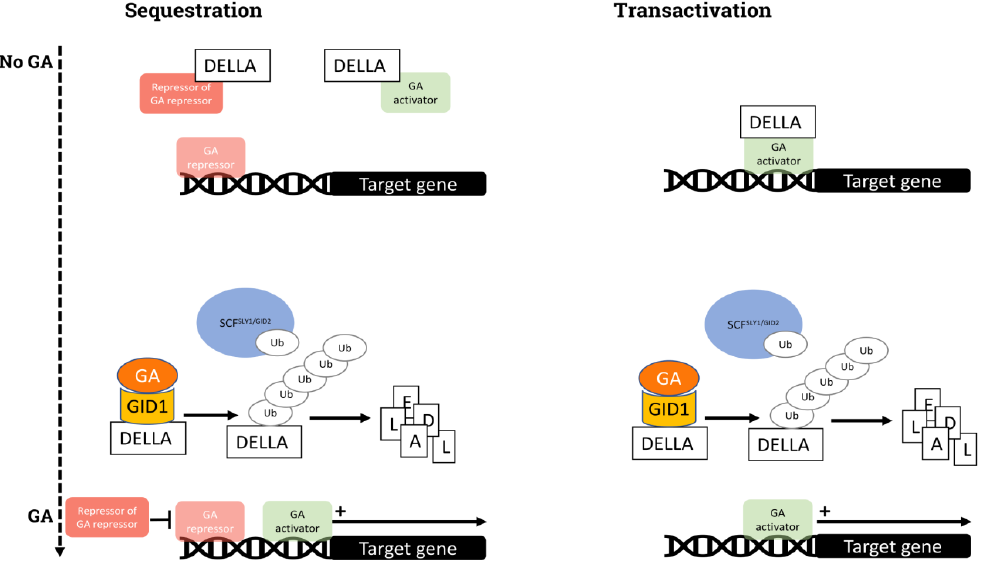
Figure 1. Simplified schematic representation of the GAs signaling mechanism. See text for details and references. Adapted from [33].